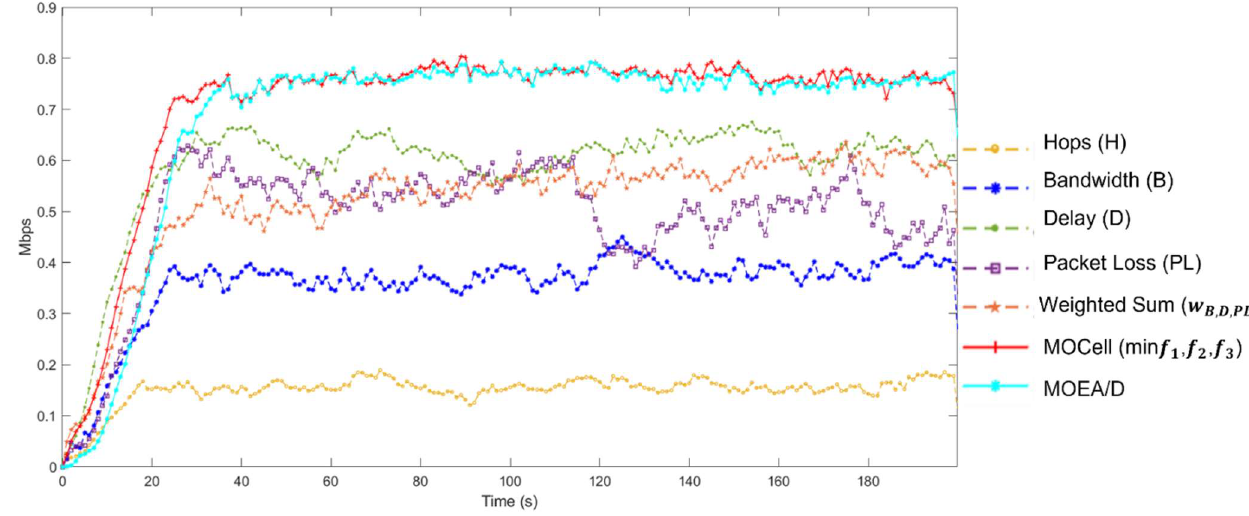
Figure 10. TCP throughput ( 𝑡 (cid:3035) ) comparison of routing paths.